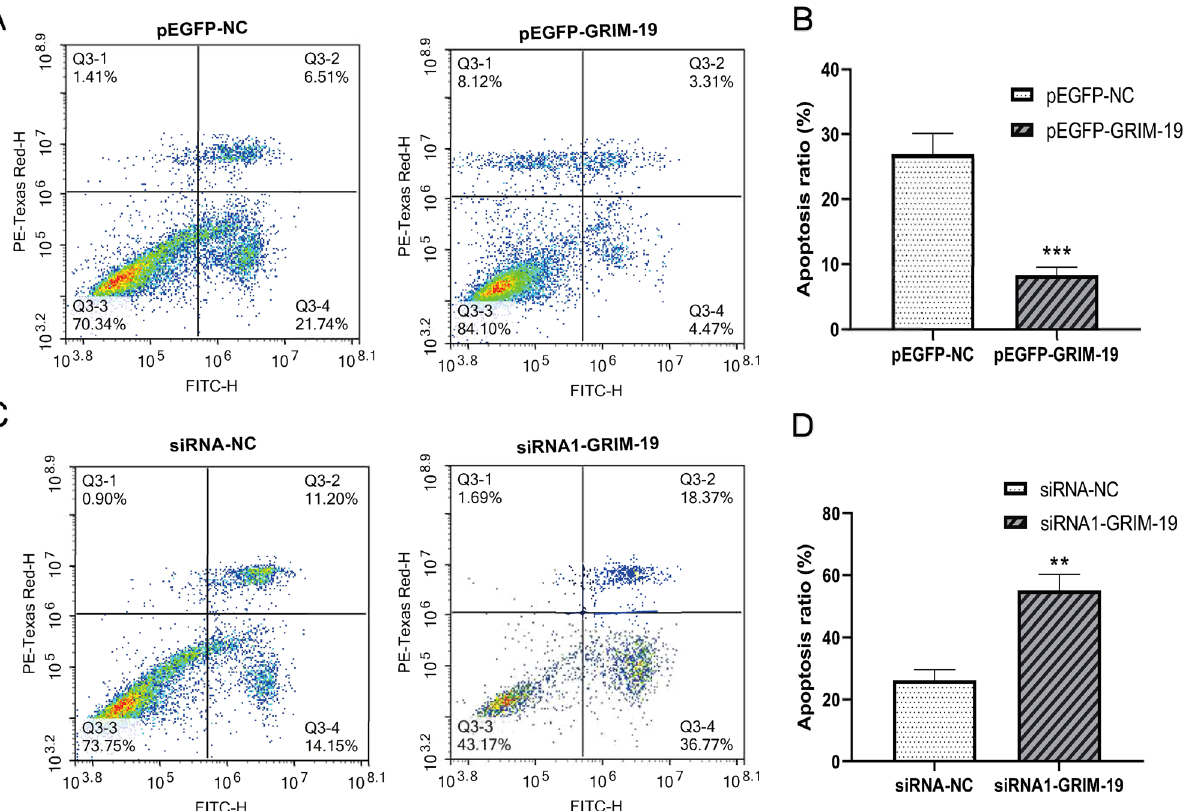
Figure 5. Apoptosis analyzed by flow cytometry. ( A ) The apoptosis of GC-2 spd cell induced by pEGFP-NC and pEGFP-GRIM-19 cells (the figure is divided into four quadrants, the upper left /Q1 represents the distribution of fragmented cells. The upper right/Q2 represents the distribution of late apoptotic cells, the lower left/Q3 represents the distribution of living cells, and the lower right/Q4 represents the distribution of early apoptotic cells). ( B ) Percentage of apoptosis in Q2 + Q4 quadrant of pEGFP-NC and pEGFP-GRIM-19 cells (26.8 ± 3.5% vs 9.7 ± 1.4%, P < 0.001). ( C ) The apoptosis of GC-2 spd cell induced by siRNA-NC and siRNA- GRIM-19 cells. ( D ) Percentage of apoptosis in Q2 + Q4 quadrant of siRNA-NC and siRNA-GRIM-19 cells (24.5 ± 3.2% vs 52.2 ± 7.3%, P < 0.01). ** p < 0.01, *** p <